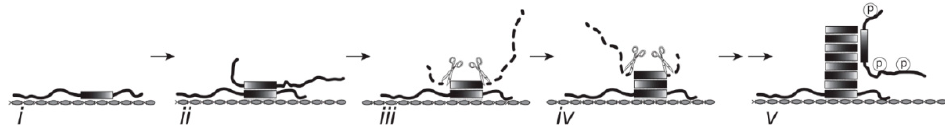
Figure 6. Schematic representation of tau-tau binding. (i) Tau is initially captured by binding to a solid-phase substrate. The identity of the endogenous substrate in the aging brain is unknown, but may be formed from macromolecular complexes which escape normal endosomal/lysosomal processing with advancing age; (ii) The tau bound to a solid-phase substrate is able to capture further full-length tau through a tau-tau binding interaction which has greater affinity (lower energy) than the physiological tau-tubulin binding interaction; (iii) This locks the repeat domain into a proteolytically stable configuration such that proteolytic cleavage of the N- and C-termini leaves behind a characteristic tau fragment restricted to the repeat domain, the core tau unit of the PHF; (iv) The oligomeric form of truncated tau is able to propagate capture and proteolytic processing of further tau, and repeated cycles of binding and proteolysis result in accumulation of PHF-core tau; (v) It is only at a later stage that non-proteolysed, full-length tau molecules are added and these become secondarily phosphorylated. The optimal points of pharmaceutical intervention are therefore blocking the binding of tau to the initiating endogenous substrate or blocking the